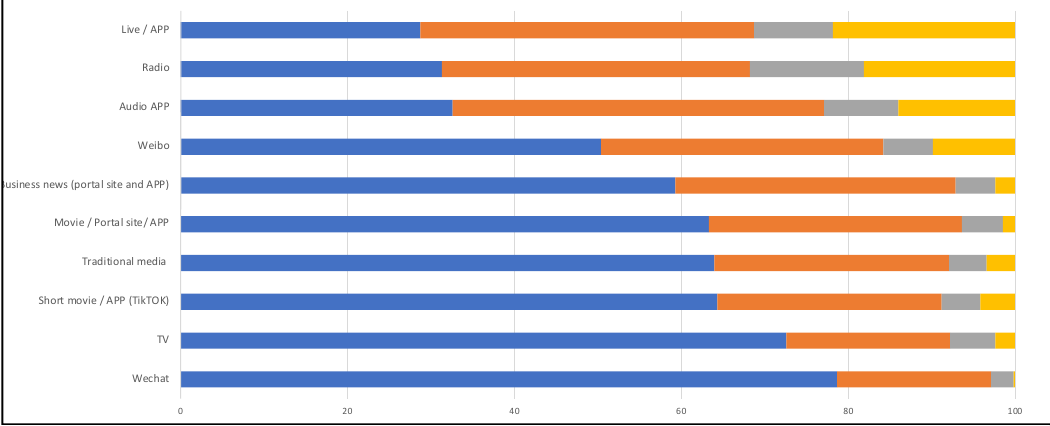
Figure 4. Use of different types of media before and after the Coronavirus spread; (Source: this figure Figure 4. Use of di ff erent types of media before and after the Coronavirus spread; (Source: this